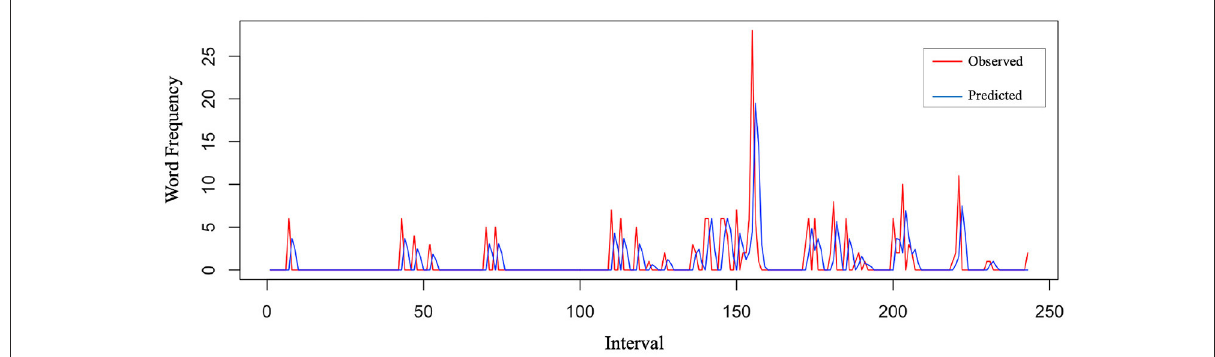
FIGURE2 Observed vs. predicted (Lombarda fear).